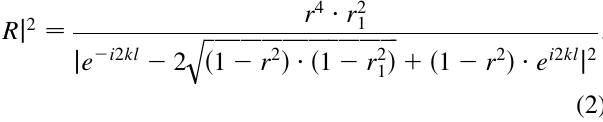
FIG. 7. Reflection of compressor vs spurious coupling factor of degenerate